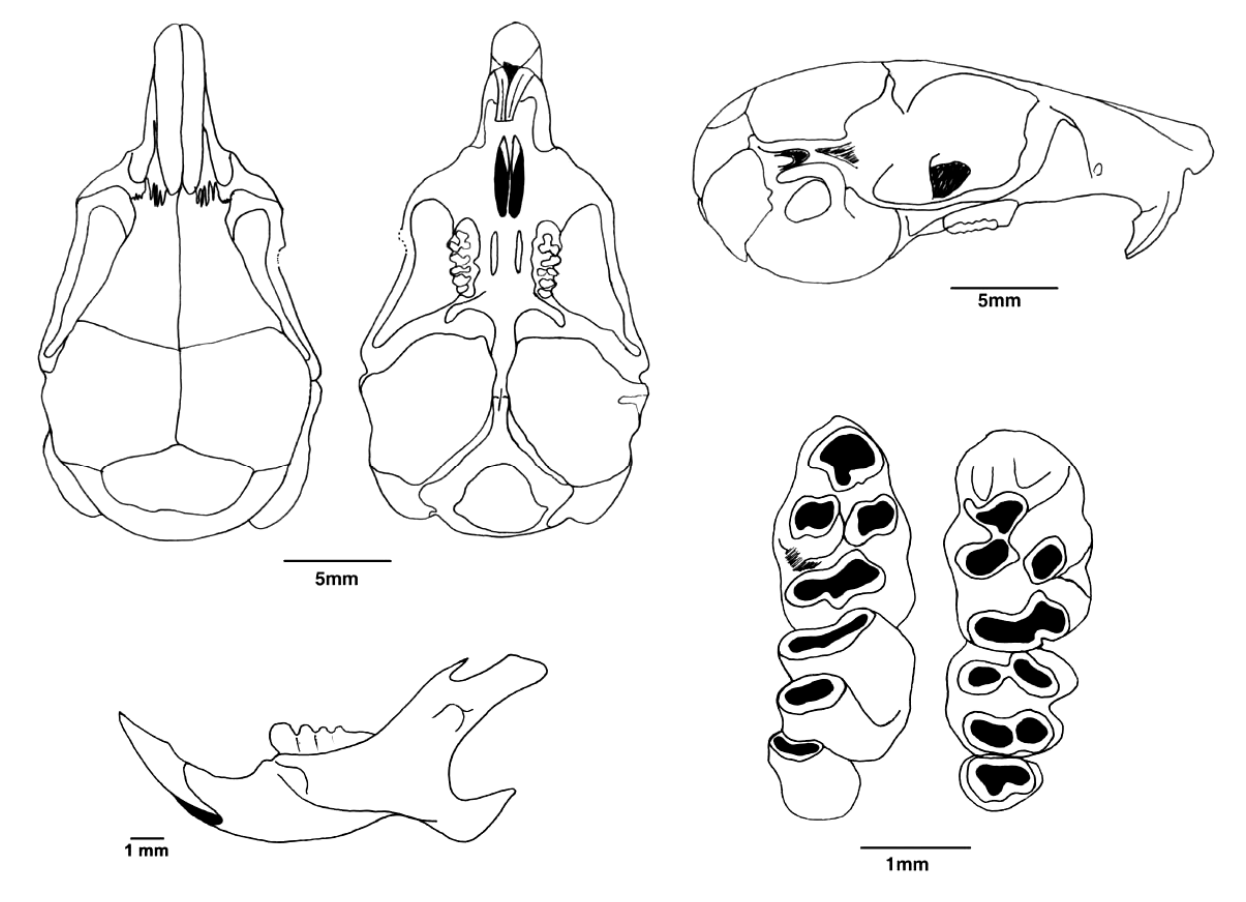
F IG 3.- Skull, mandible and teeth of the Gerbillus cfr. henleyi from